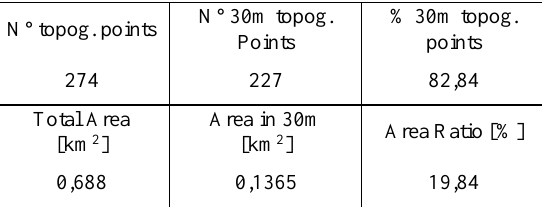
Table 1. Statistics of linear extent surveys.